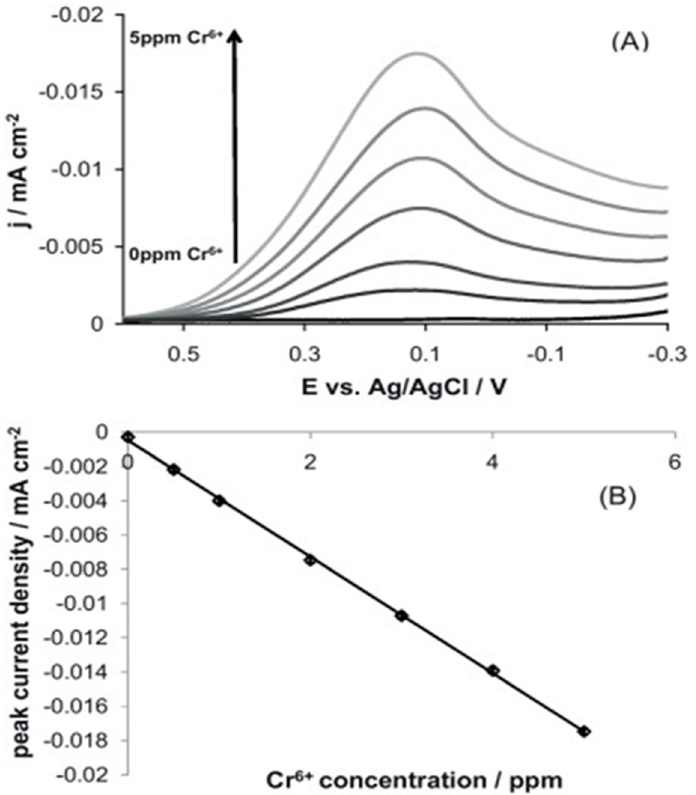
Figure 6. ( A ) Linear scan voltammograms of Cr 6+ (concentration range between 500 ppb and 5 ppm) in 0.1 M HNO 3 recorded on a BDD electrode at 50 mV s − 1 and between 0.6 and − 0.3 V vs. Ag/AgCl sat. T = 23 ◦ C. ( B ) Chromium detection calibration curve: the peak current density reported in ( A ) was plotted as a function of Cr 6+ concentration (slope: − 3.41 × 10 − 3 ± 3 × 10 − 5 , y-intercept: − 4.8 × 10 − 4 ± 9 × 10 − 5 , r 2 : 0.999) (reproduced with the permission of [78]).